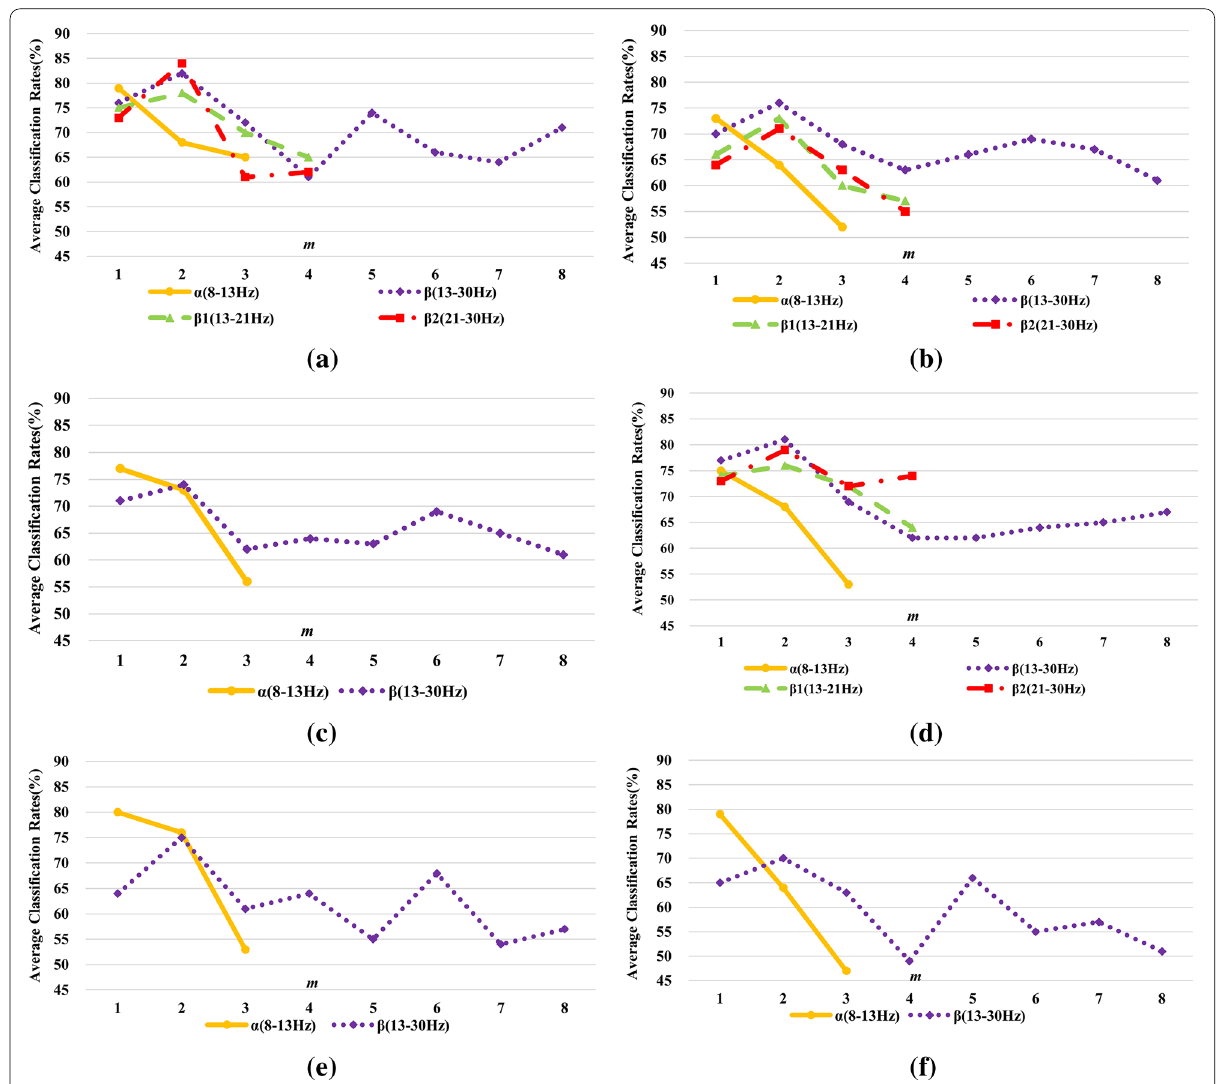
Fig. 13 Effects of different frequency bands and m values on the classification results for a S1, b S2, c S3, d S4, e S5, f S6, g S7, h S8 and i S9 on Dataset